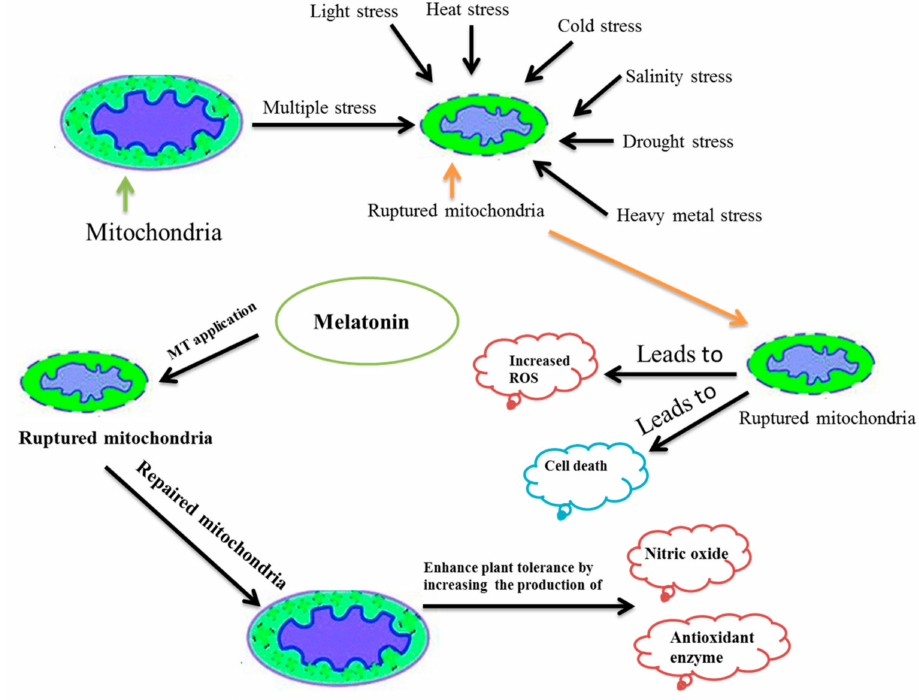
Figure 1. Schematic representation of melatonin defense mechanism